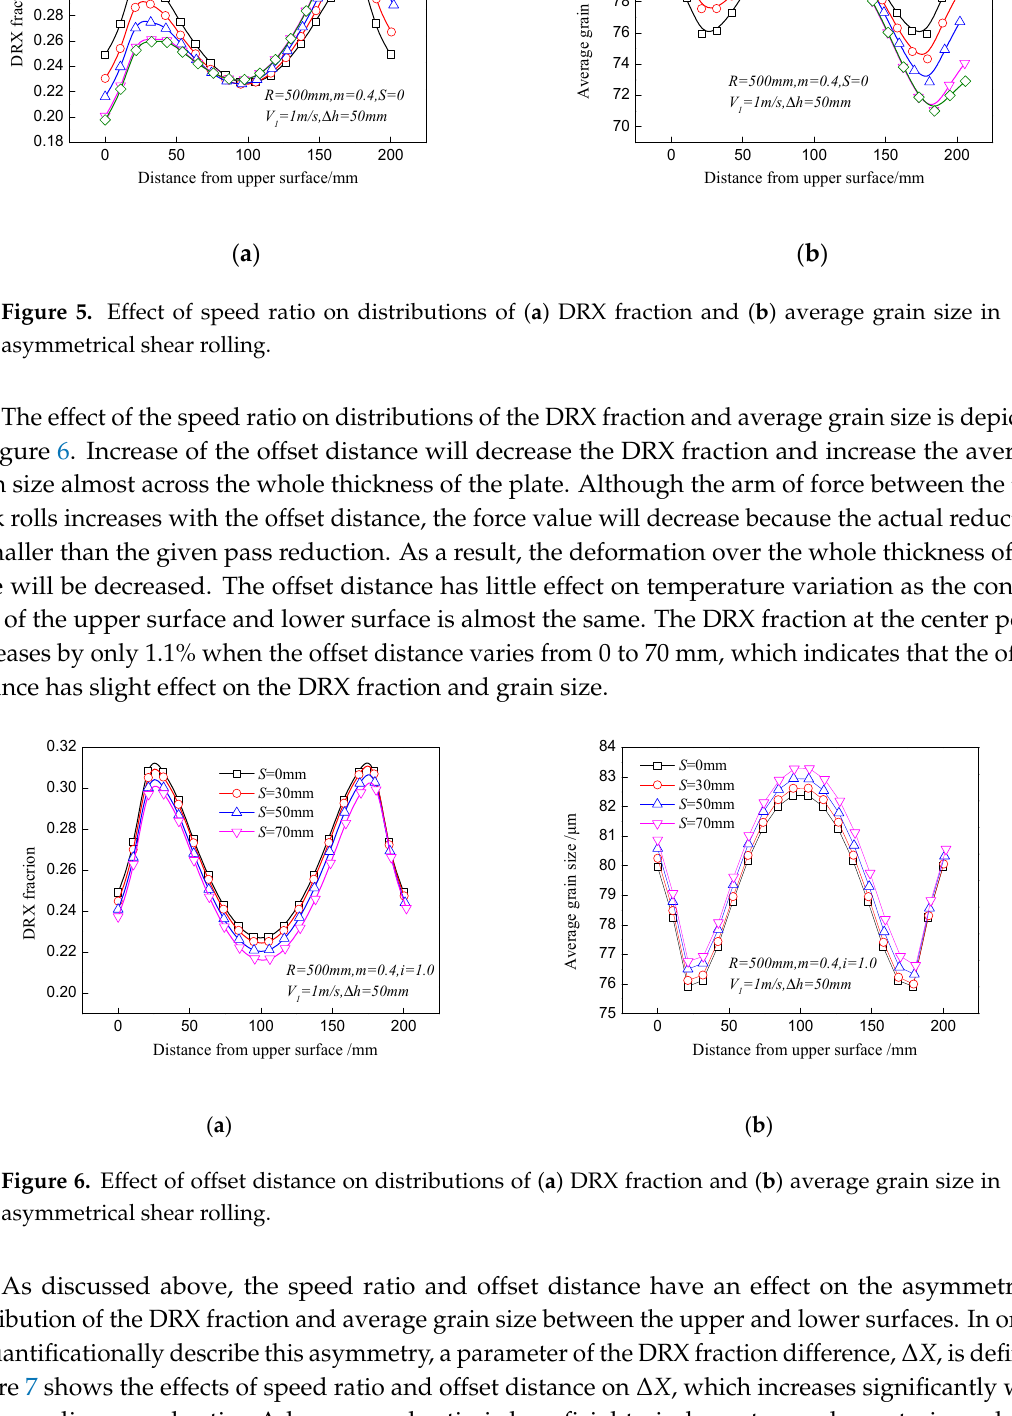
Figure 6. Effect of offset distance on distributions of ( a ) DRX fraction and ( b ) average grain size in asymmetrical shear rolling.